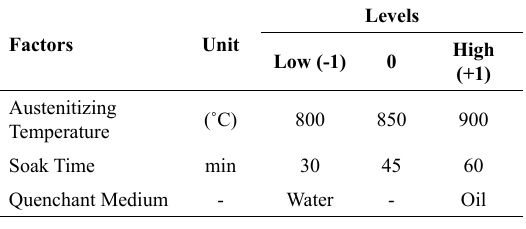
Figure 1. Navy C-rings samples: A) outside diameter; B) inner diameter; C) gap opening; D) thickness. Table 2. Important factors and their